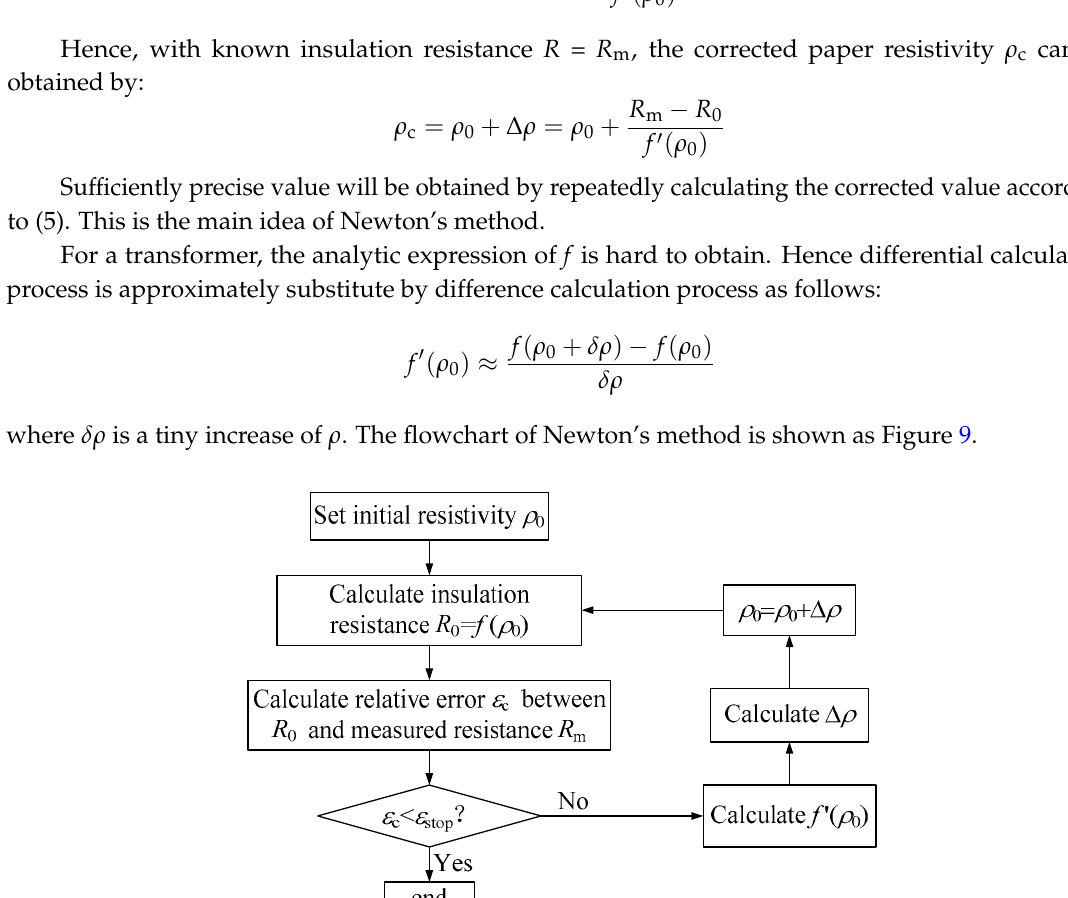
Figure 10. Calculation results using different iterative method.